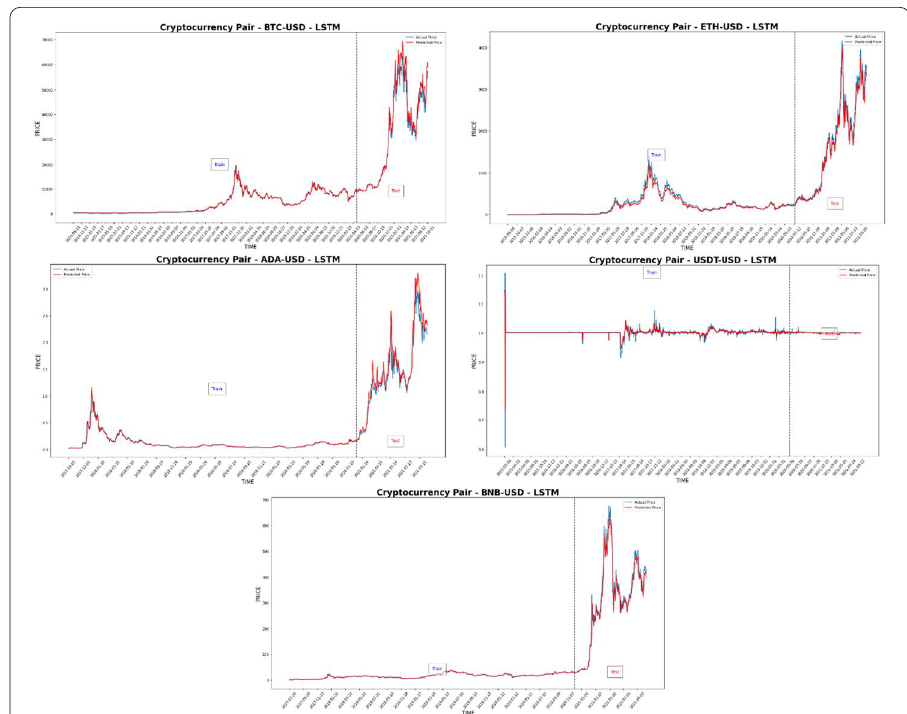
Fig. 5 Prediction results for five cryptocurrencies using LSTM